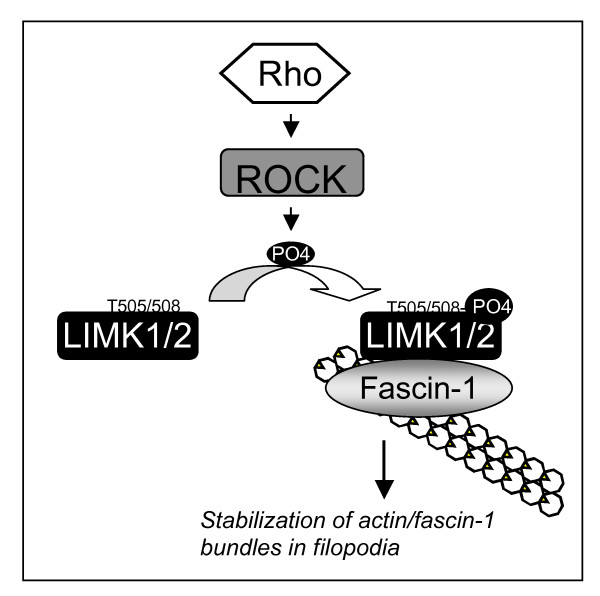
Model for the novel pathway that regulates fascin-1/actin interaction and filopodia stability. See Discussion for details. As shown in Figure 6, active p-Lin-11/Isl-1/Mec-3 kinase (LIMK)1/2 bound to both S39-phosphorylated and non-phosphorylated fascin-1.